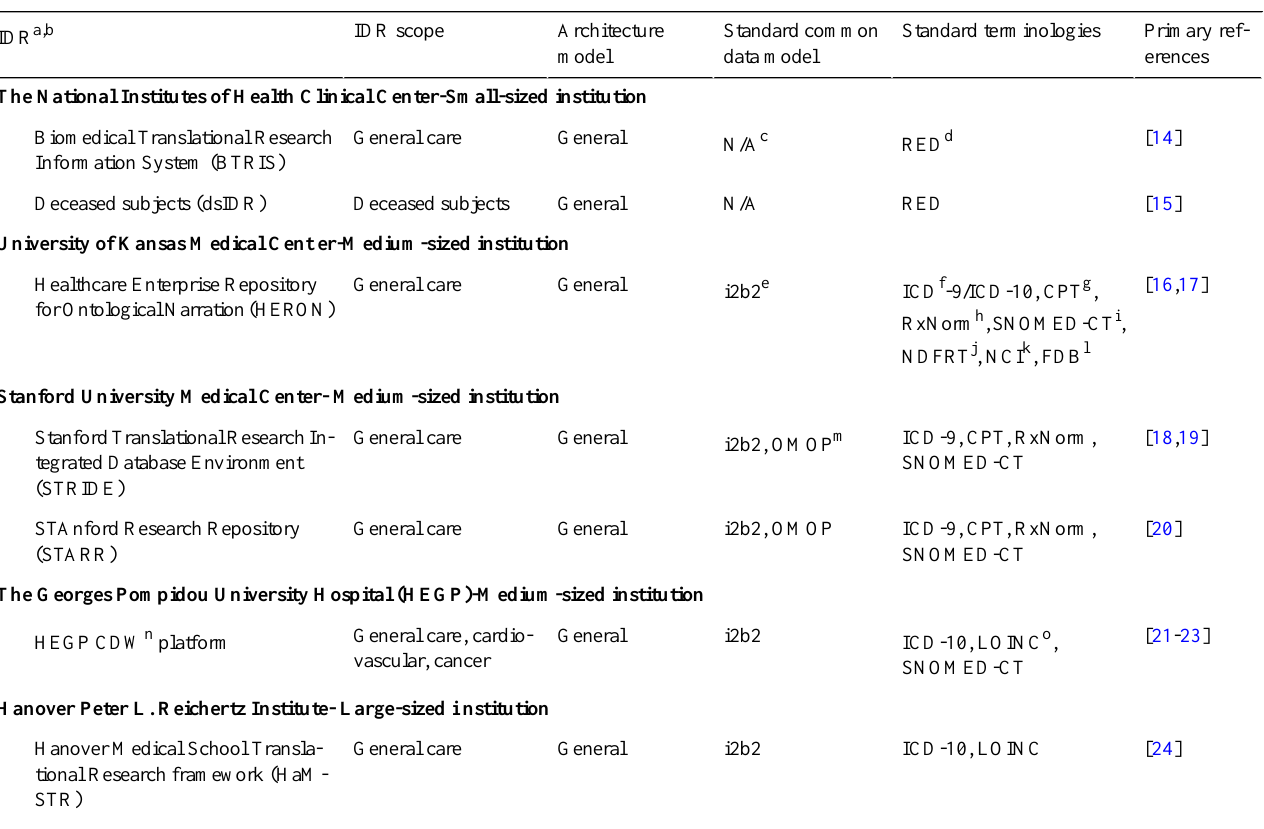
Table 1. Institutions and major features of the integrated data